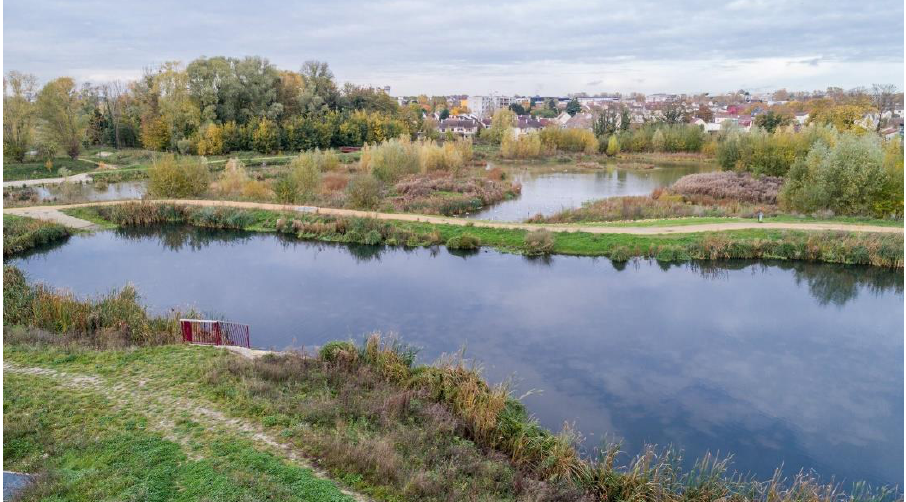
Figure 7. Newly created wetlands: river expands to a larger floodplain, thus preventing flooding in neighbouring settlement while providing habitats for many species © SIAH: Syndicat Intercommunal d’Aménagement Hydraulique of Croult and Petit Rosne.